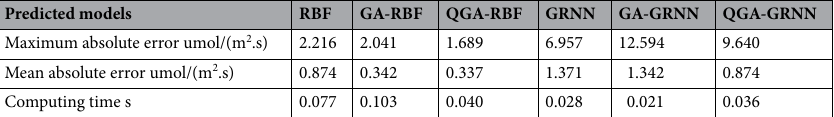
Table 2. Evaluation index of prediction model based on different artificial intelligence